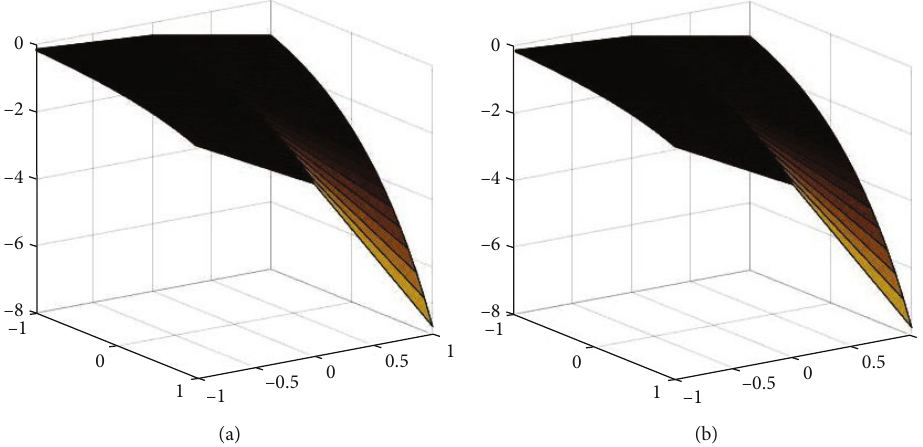
Figure 7: (a) Actual and (b) SDM/q-HATM result of μ ð χ , ξ , I Þ at δ = 1 .